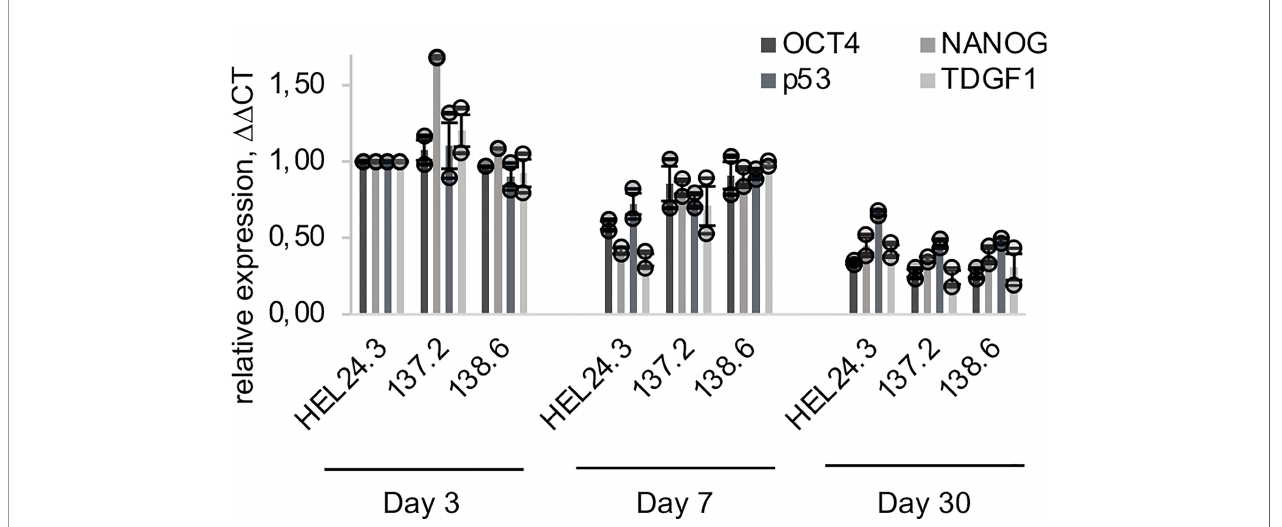
FIGURE 5 | qPCR quanti fi cation of OCT4, NANOG , p53 and TDGF1 expression in APECED and healthy person iPS-derived EBs. The relative mRNA expression in APECED EBs (137.2 and 138.6) and a healthy control (HEL24.3) EBs presented as a mean of DD Ct fold change of 2 independently analyzed biological replicates (shown as circles), normalized to the healthy control HEL24.3 day 3 sample. Error bars of the circles represent SD within a replicate. Error bars of the bars represent SEM of the two